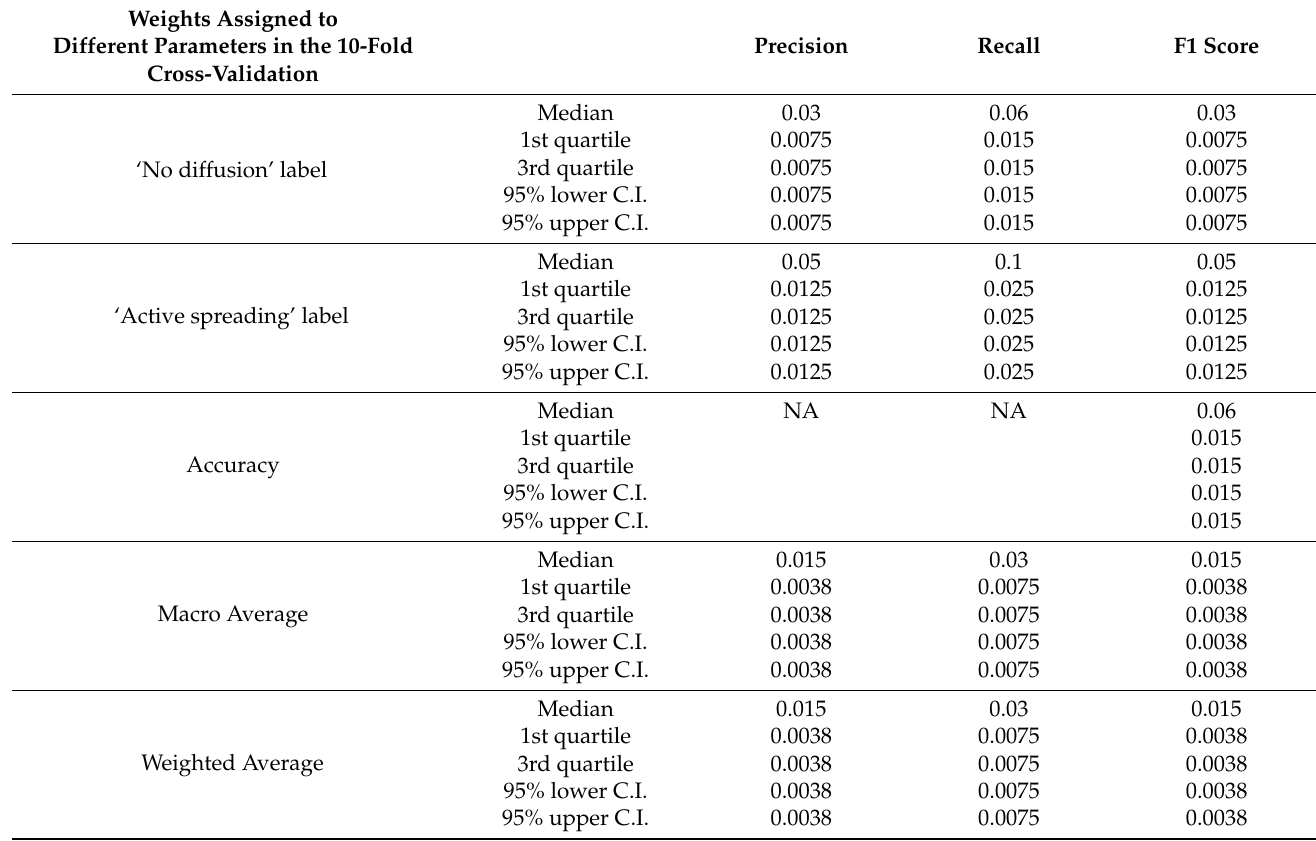
Table 2. Weights applied for the different metrics (precision, recall, F1 score), computed for the ‘no diffusion’ label, ‘active spreading‘ label, and for the whole dataset, to evaluate the performance of a machine learning algorithm trained to identify these two scenarios, as resulting from a 10-fold cross- validation protocol; the median, first quartile, third quartile, and lower and upper 95% confidence interval values across the distribution among the 10 folds are reported (i.e., the median value of recall for the ‘active spreading’ label was weighted